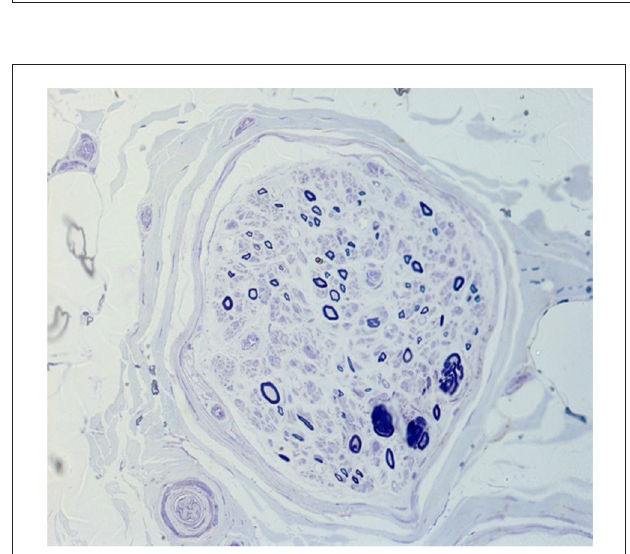
( Figure 3 ). The underlying mechanism of peripheral nerve involvement in some MADD patients is unclear, and a possible explanation is that an aberrant lipid metabolism, such as accumulation of acylcarnitine lipid intermediates and reduction of myelin lipid components in Schwann cells can induce demyelination and axonal degeneration.